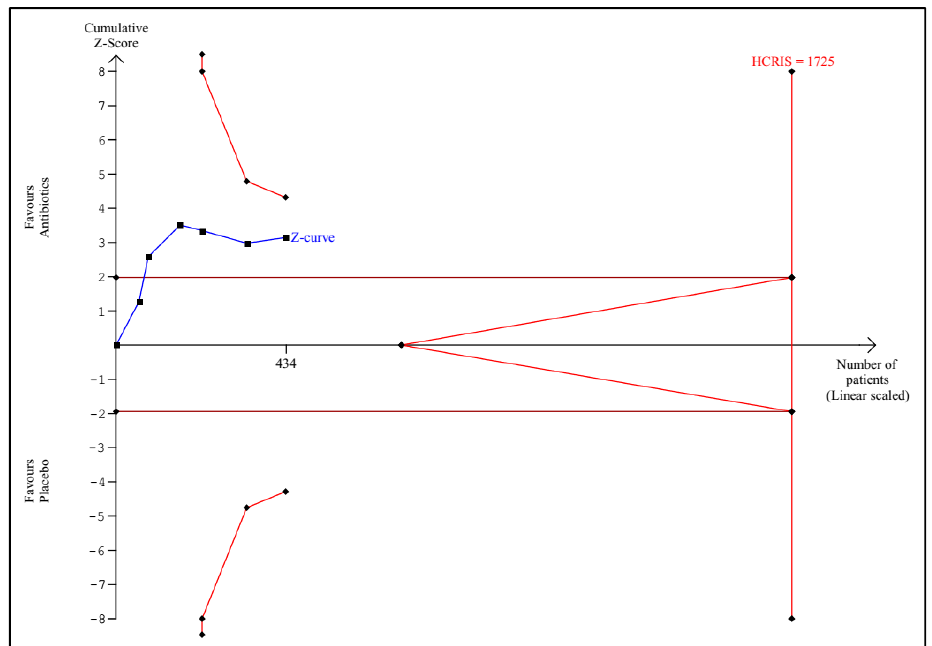
Figure 7. Trial sequential analysis for sepsis. The calculated HCRIS is 1725 patients. A total of 434 patients were randomized (25% of the HCRIS). The Z-curve crossed the conventional boundaries for p = 0.05, but not the monitoring boundaries. The calculation was performed with a heterogeneity of 0%, proportion of patients with sepsis in the control group of 15%, an RRR of 30%, an alpha of 5%, and a beta of 20%; HCRIS = heterogeneity-corrected required information size.